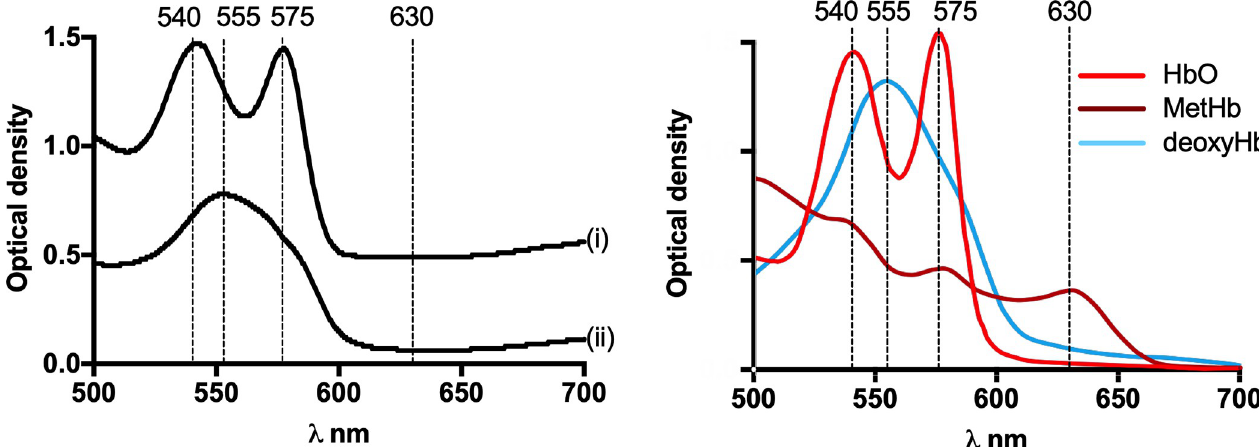
Fig 5. (a) Absorbance spectra (nm) of (i) fresh drawn chicken blood and (ii) the an aliquot preserved in lithium heparin at 6˚C for 24 hours in the laboratory. (b) Optical density of oxyhaemoglobin (HbO), methaemoglobin (MetHb) and deoxyhaemoglobin (deoxyHb) as reported by Van Kampen and Zijlstra (1966). https://doi.org/10.1371/journal.pone.0282820.g005 a useful relative indicator of declining HbFe 2+ in birds dosed with PAPP that closely corre-